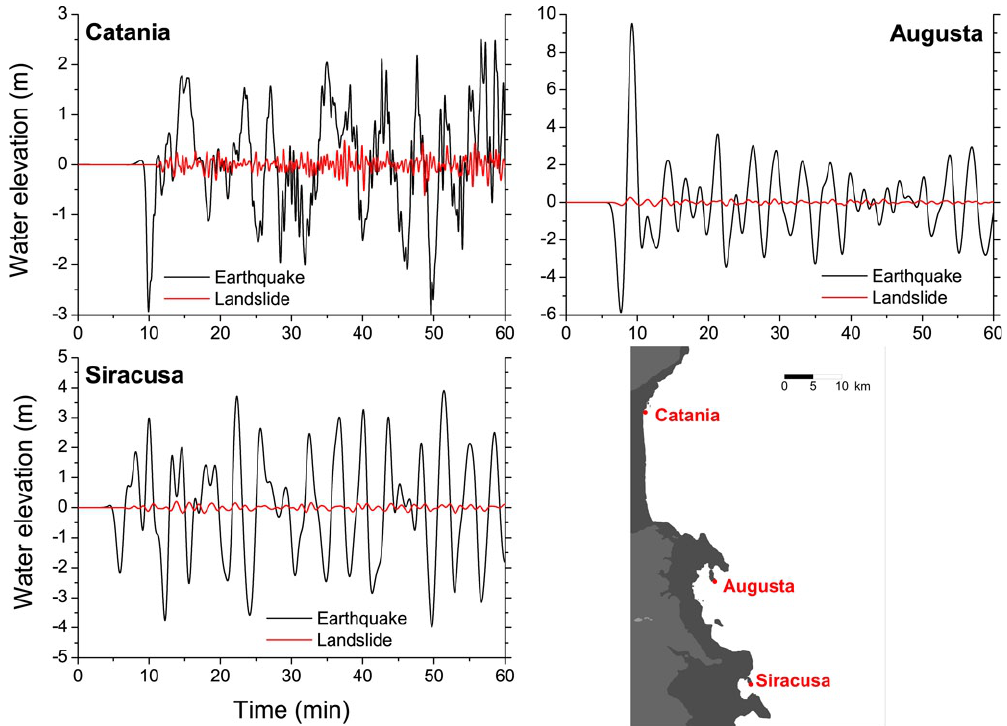
Fig. 7. Synthetic marigrams in the cities of Catania, Augusta and Siracusa computed for the active fault and for the landslide tsunamis. The localities are indicated in the bottom, right